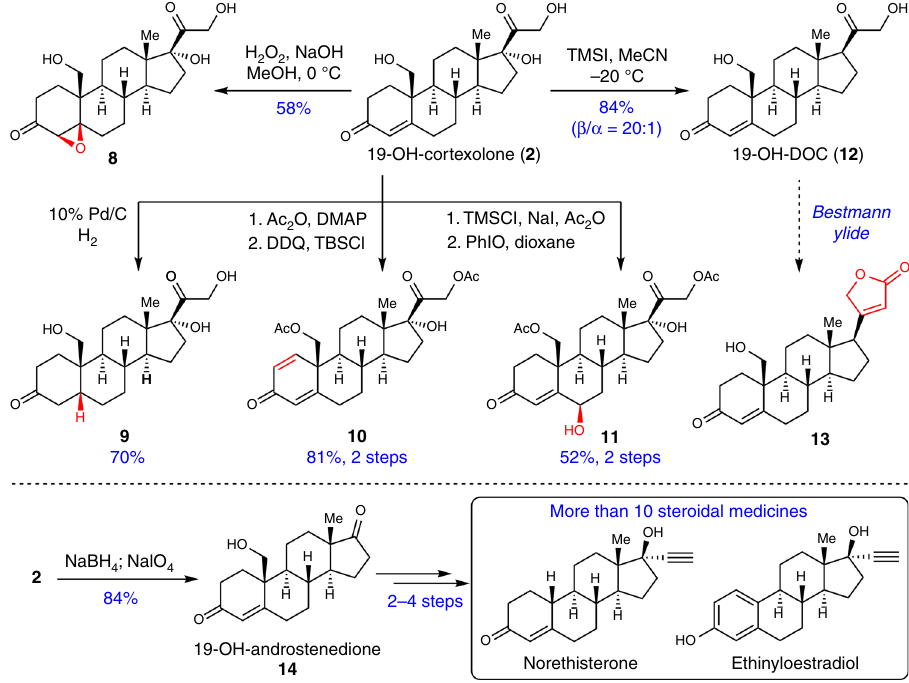
Fig. 3 Synthetic transformations of 19-OH-cortexolone. 19-OH-cortexolone was readily transformed into various synthetically useful steroidal intermediates through epoxidation, hydrogenation, desaturation, allylic oxidation, cleavage of the C17-hydroxy group or the side chain